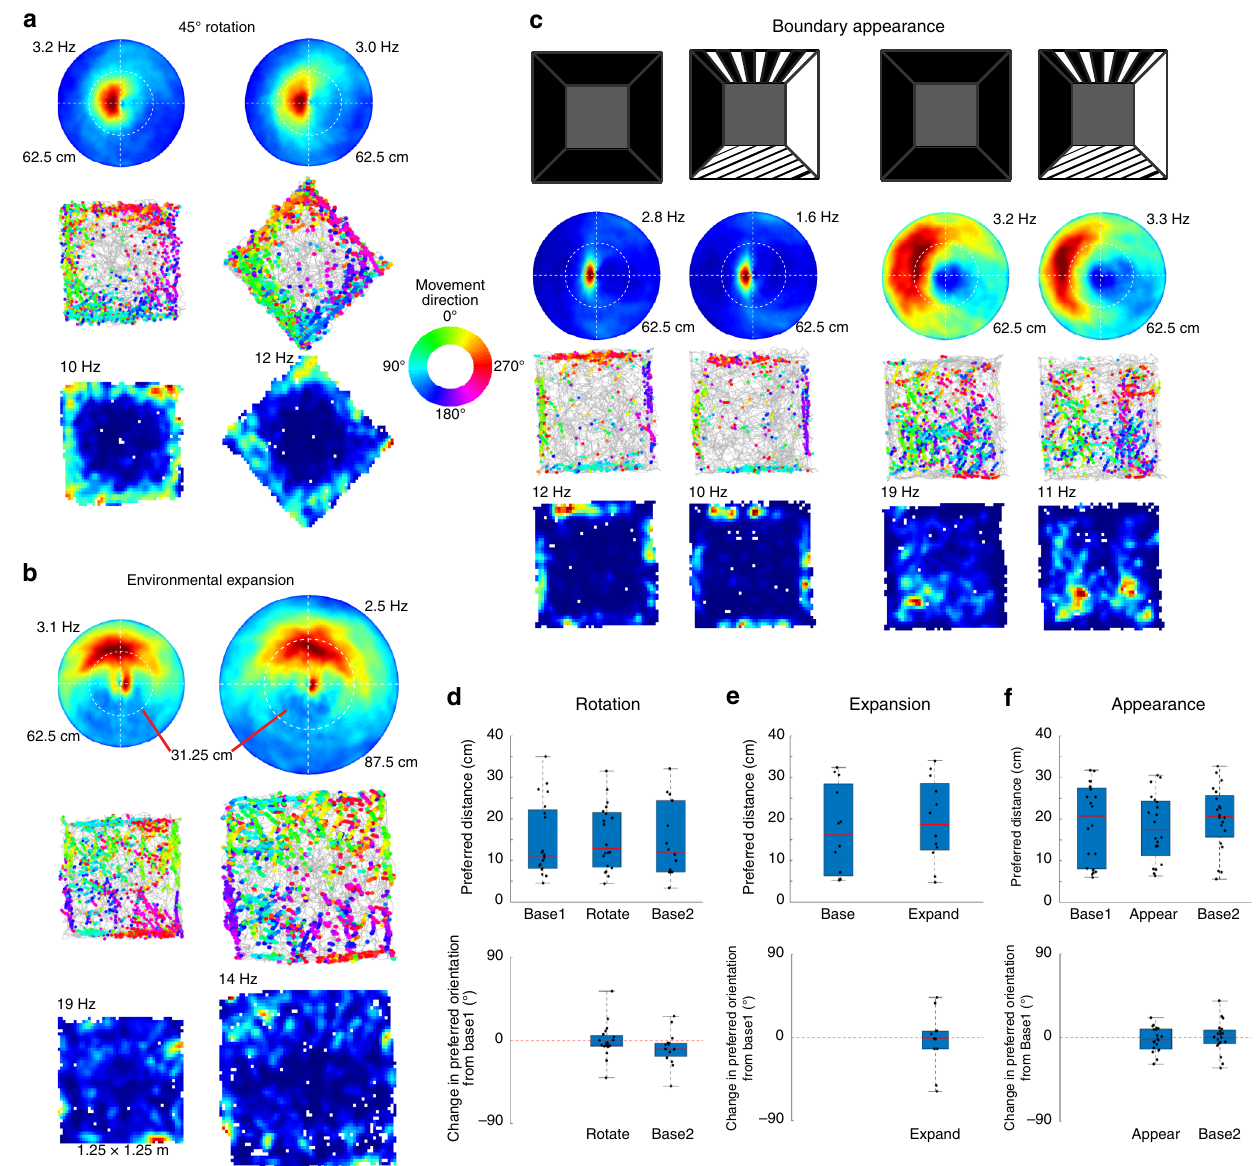
Fig. 3 Egocentric boundary cells (EBCs) respond stably to local environmental boundaries. a Egocentric boundary ratemaps with maximum fi ring rates indicated above each plot, trajectory plots with color-coded movement direction spike locations, and allocentric spatial ratemaps with maximum fi ring rates indicated above each plot (top to bottom) for an EBC during a baseline and 45° environmental rotation session (left to right). b Same plots as in a , but for the standard 1.25 × 1.25 m 2 environment and an expanded 1.75 × 1.75 m 2 environment. c Same plots as in a , but for two EBCs (left to right) during recordings with the standard black walls and patterned walls. d – f Box plots of preferred distance (top) and change in preferred orientation from baseline (bottom) where the top and bottom of each box represent the fi rst and third quartile, the red line indicates the median and the whiskers indicate the full range of values for ( d ) the rotation experiment (preferred distance: Base1: 25th: 8.05, 50th: 11.06, 75th: 22.16 cm, Rotate: 25th: 8.42, 50th: 12.88,